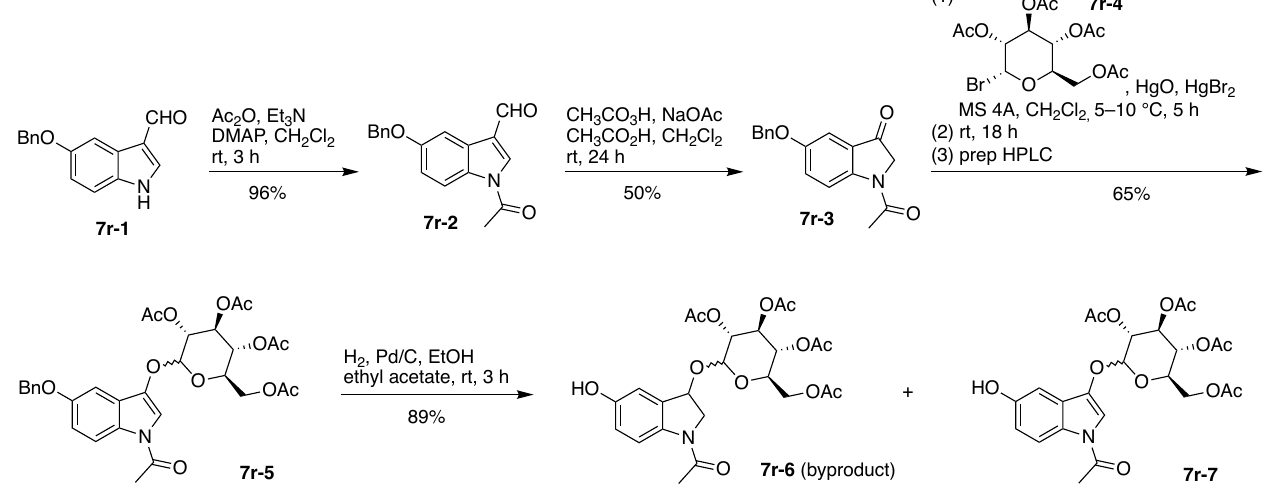
Figure 18. Synthesis of β-indoxyl-glucoside.